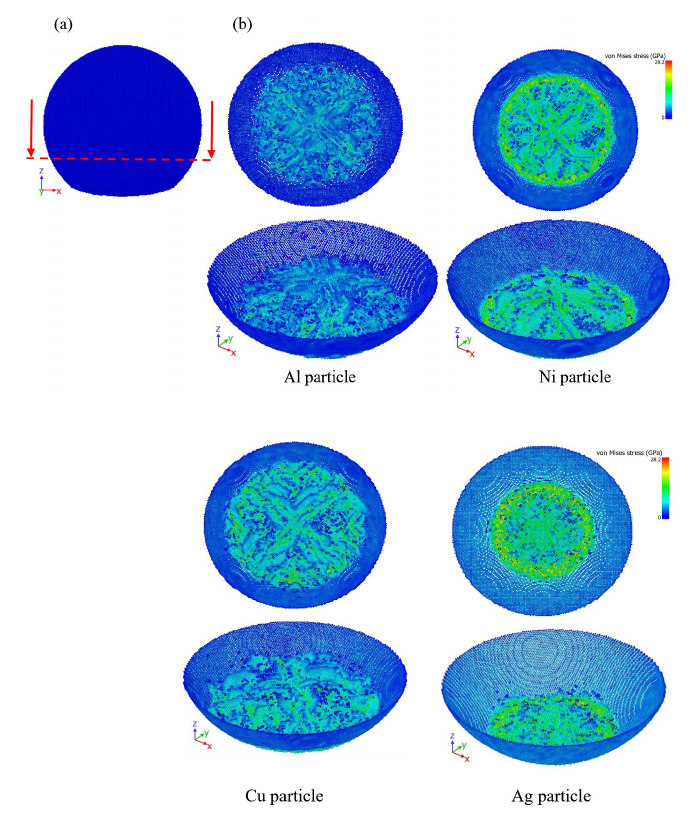
Figure 6. ( a ) Deformed particle diagram where arrows show the observation path and ( b ) von Mises stress evolution on the particle bottom after 5 ps in CGDS of the defects induced by impact.